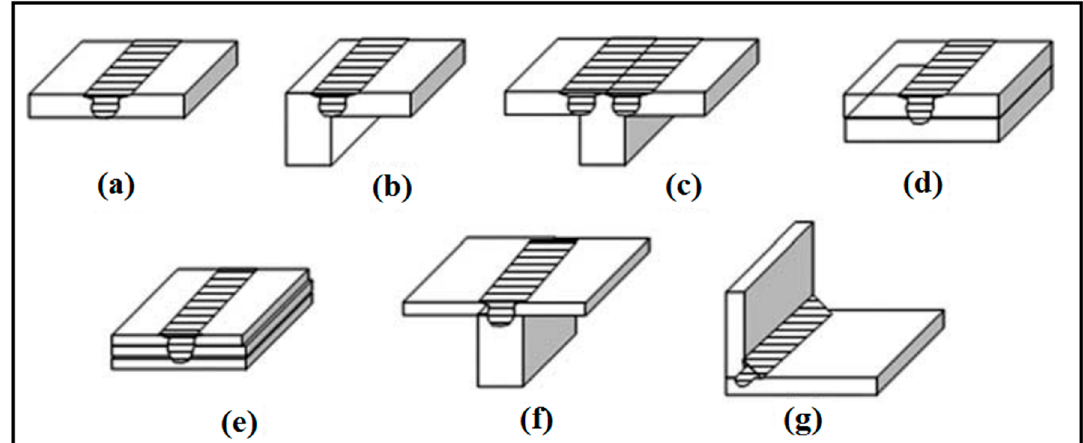
Figure 2. Joint configurations for friction stir welding: ( a ) square butt, ( b ) edge butt, ( c ) T butt joint, ( d ) lap joint, ( e ) multiple lap joint, ( f ) T lap joint, and ( g ) fillet joint (Reprinted with permission from ref. [91]. Copyright 2005 Elsevier